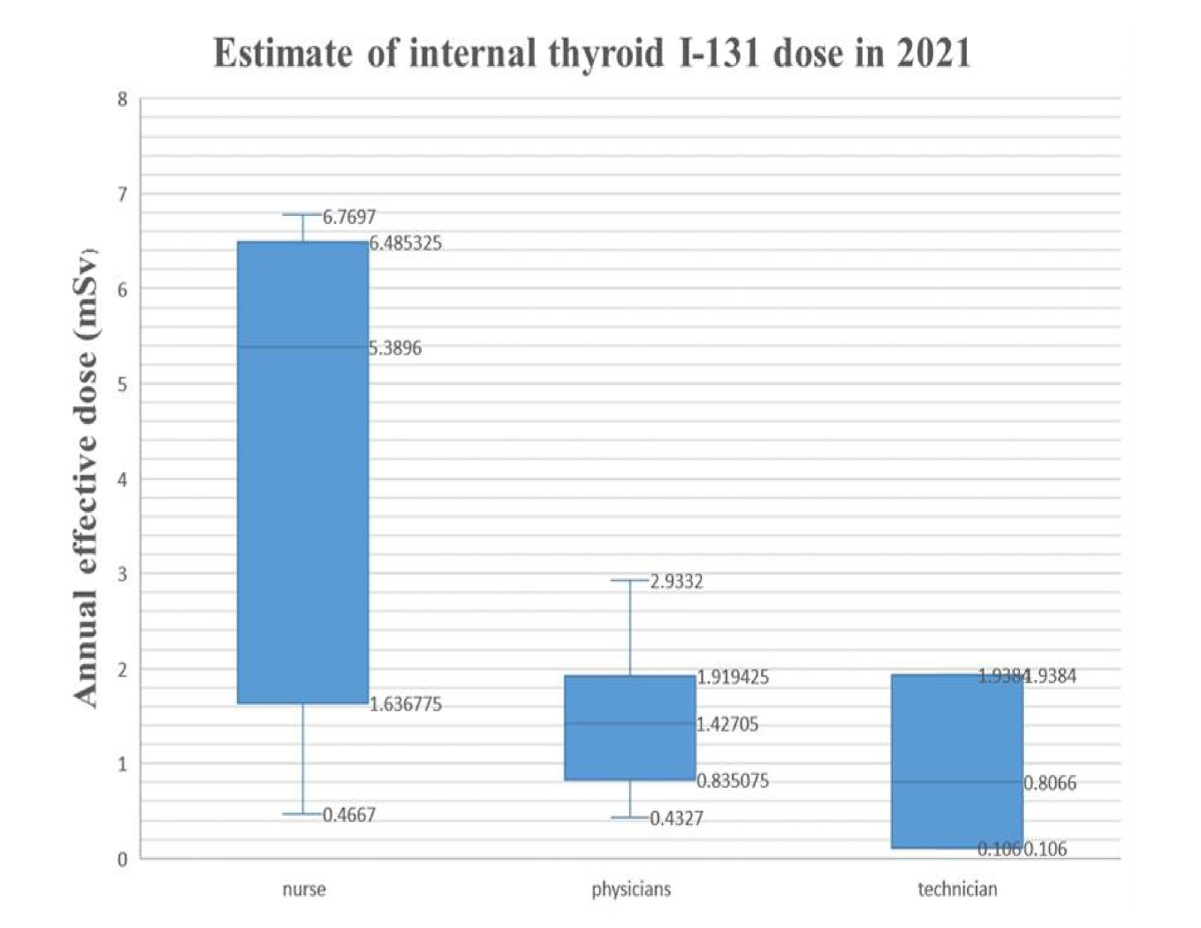
FIGURE3 Estimate of internal thyroid 131 I annual effective dose (mSv) in 2021.